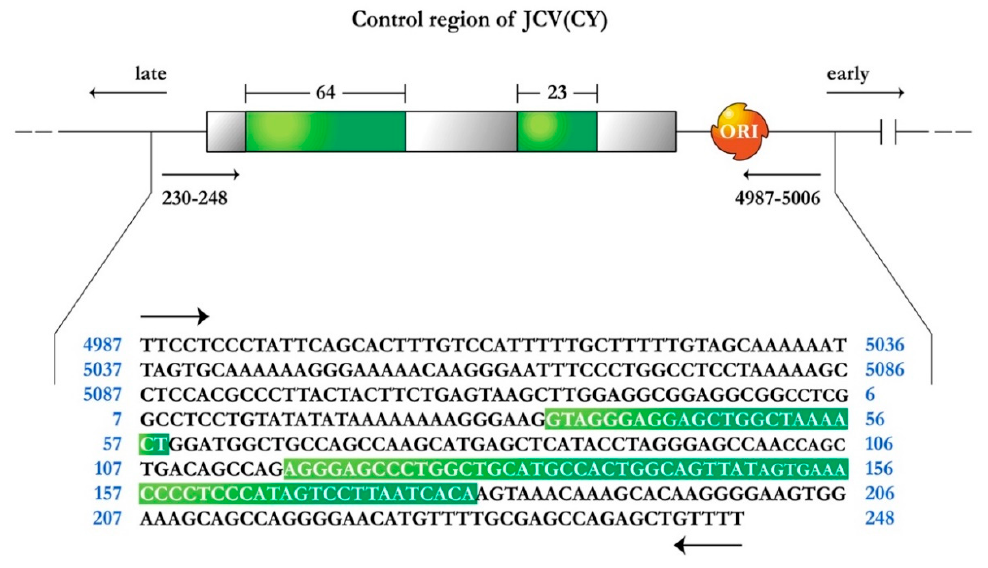
Figure 1. Schematic representation of the JC Virus archetype strain CY, control region. Green boxes indicate the 64 and 23 base pair sequences that are not present in the Mad1 strain within the 98 base pair promoter/enhancer sequence, now divided into three empty gray boxes of 25, 55, and 18 base pairs. Arrows indicate the direction of early and late gene transcription. ORI represents the origin for viral DNA replication. The nucleotide sequence of the control region is shown below, depicting the 64 and 23 insertions (green